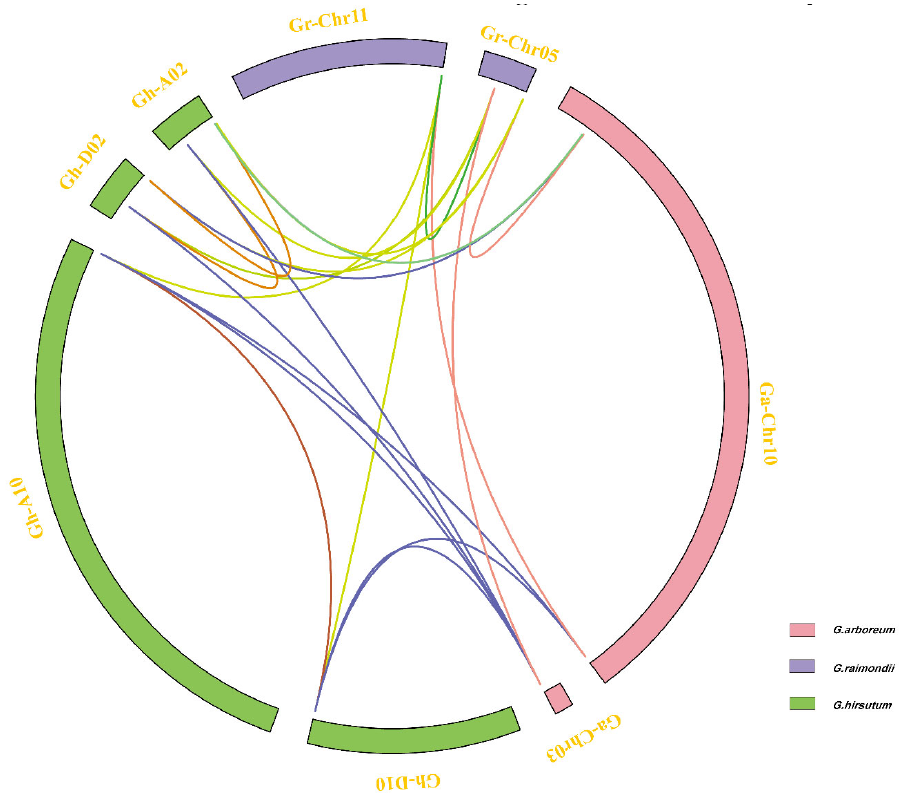
Figure 2. The collinearity relationships of Filamin gene family members of three cotton species. The chromosomes of G. arboreum , G. raimondii and G. hirsutum are shown with pink, blue and green colors, respectively.